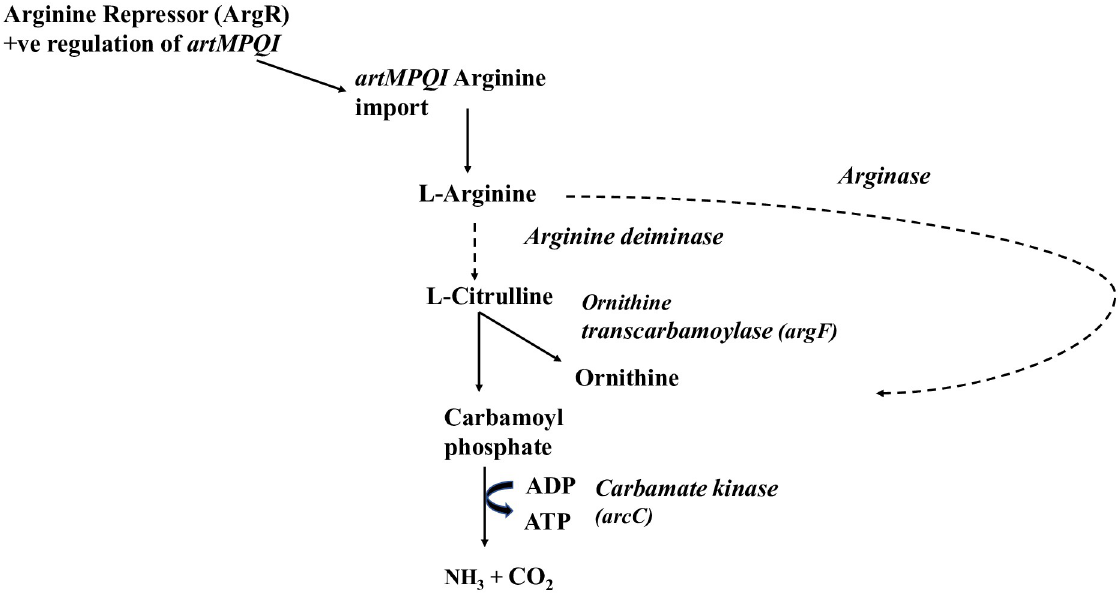
Fig 6. Arginine import and catabolic pathways in H . influenzae 86-028NP as determined from KEGG pathway analysis. Pathways for which genes have been identified in 86-028NP are indicated with black line, and pathways for which genes are missing in 86-028NP are indicated with dashed